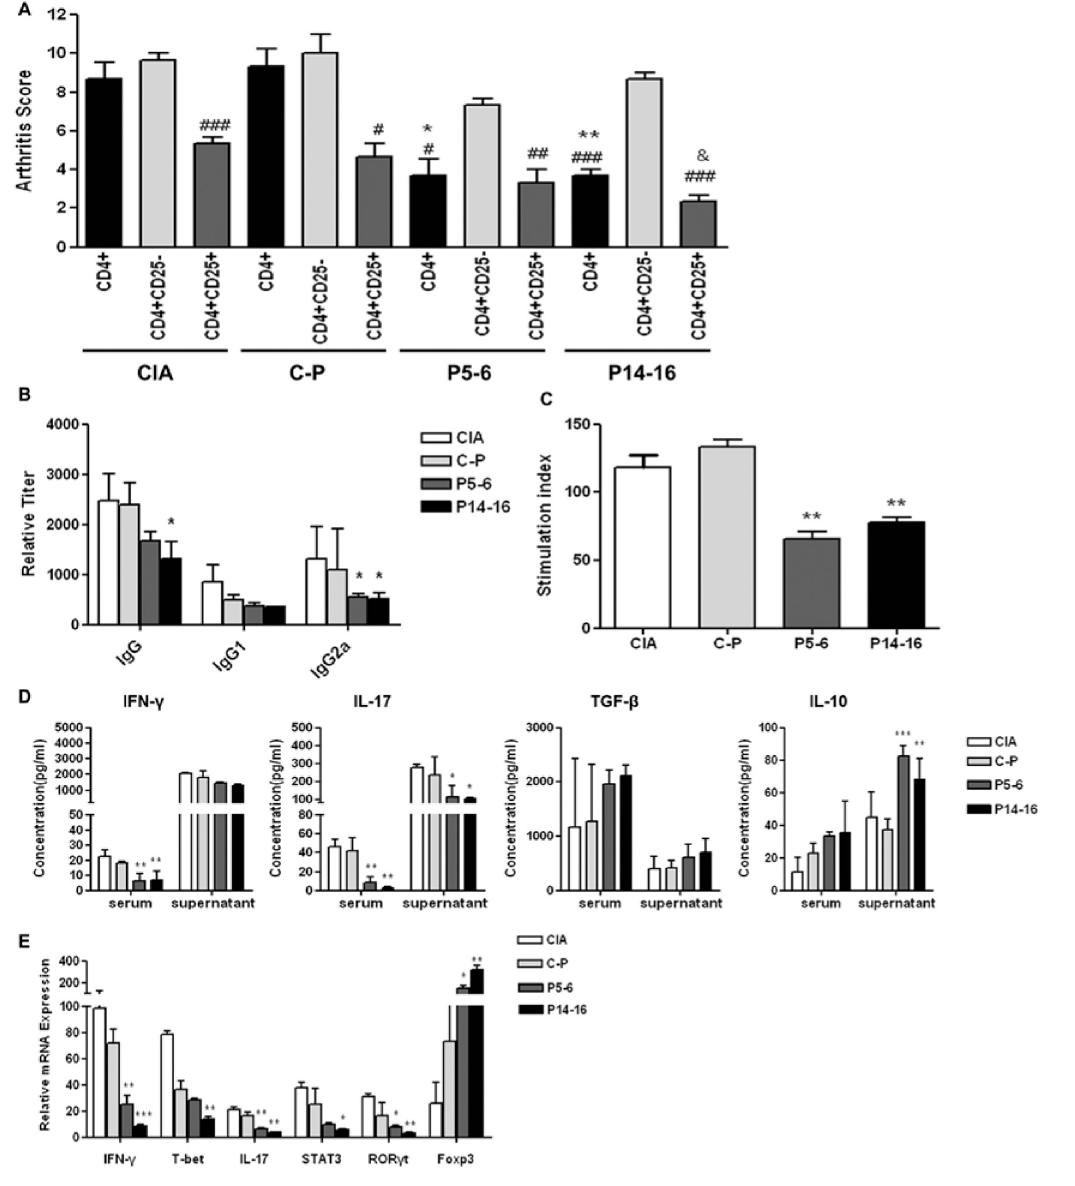
Figure 6. Prevention of CIA by in vivo ergotype peptide–induced Treg. (A) Total CD4 + T cells, CD4 + CD25-T cells or CD4 + CD25 + T cells derived from CIA or peptide-treated CIA mice were transferred into naive DBA/1 through intravenous injection. On the same day, naïve mice were induced with CII. Severity of arthritis was assessed by scoring clinical features 2 wks after the adoptive transfer. Values are the mean ± SD of 10 mice per group. *: P < 0.05, **: P < 0.01 versus C-P group; #: P < 0.05, ##: P < 0.0, ###: P < 0.001 versus internal CD4 + CD25–; &: P < 0.05 versus C-P group. (B) The levels of CII-specific IgG, IgG1 and IgG2a in sera collected on d 14 post adoptive transfer were determined by ELISA. Data are represented as mean ± SD. *: P < 0.05 versus C-P group. (C) Mononuclear cells from the spleens of transferred mice were isolated and stimulated with CII at 20 μ g/mL. H 3 –TdR (1 μ Ci/well) was added at 48 h and cell proliferation was assessed at 72 h. The stimulation index normalized to unstimulated controls is displayed. Data are represented as mean ± SD. **: P < 0.01 versus C-P group. (D) The expressions of Th1, Th17 and Treg related cytokines IFN- γ , IL-17, TGF- β and IL-10 were measured by ELISA in sera and in supernatants by splenic mononuclear cells with CII stimulation (20 μ g/mL) for 48 h. Values are the mean ± SD of 10 mice per group. *: P < 0.05, **: P < 0.01, ***: P < 0.001 versus C-P group. (E) mRNA levels of IFN- g , T-bet , IL-17 , STAT3 , ROR g t and FOXP3 in splenic mononuclear cells stimulated with CII (20 μ g/mL) for 24 h were measured by real-time qPCR. Values are represented as mean ± SD. *: P < 0.05, **: P < 0.01, ***: P < 0.001 versus C-P group. Data are representative of three separate experiments with similar